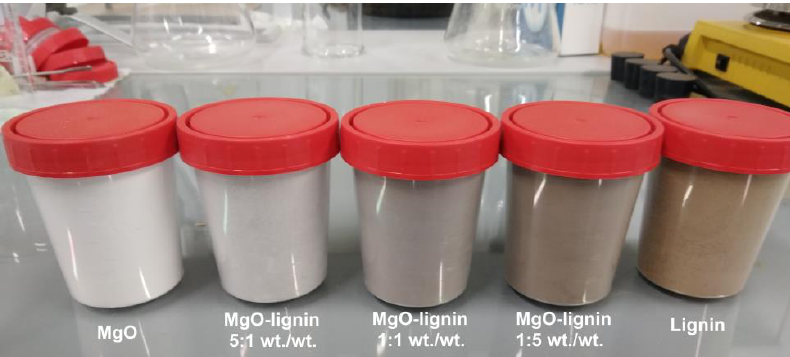
Figure 1. Digital photo of the obtained hybrid fillers.